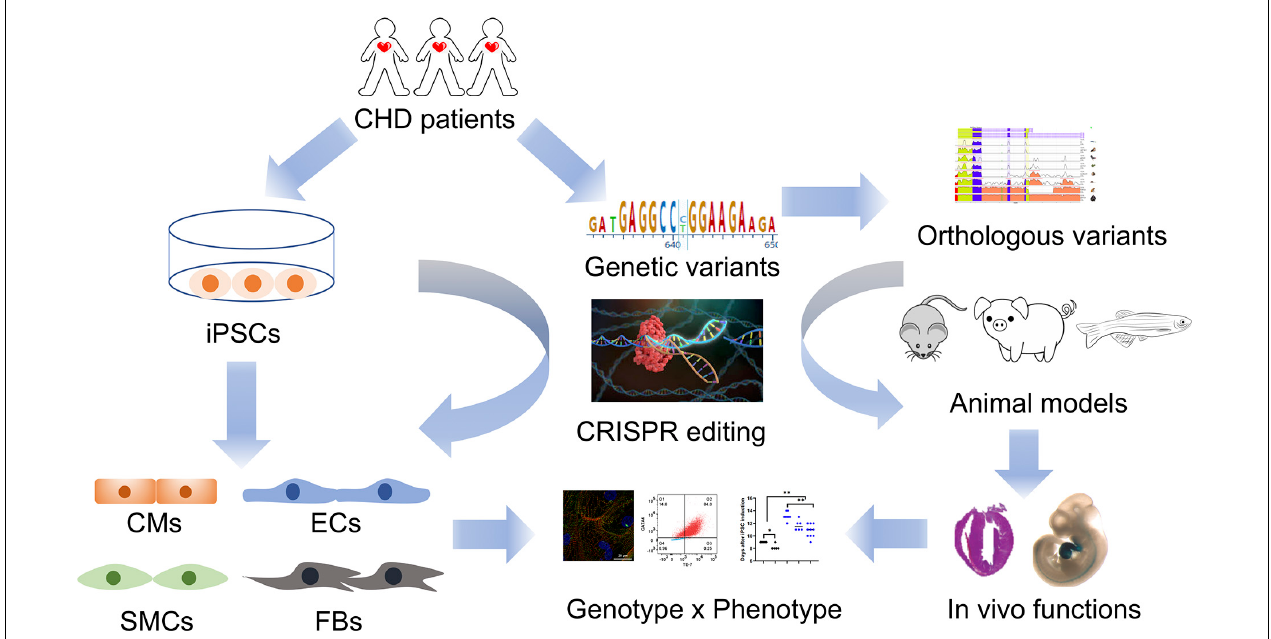
FIGURE 1 | An integrated patient-specific iPSC model for studying genetics of CHD. Whole genome sequencing of CHD patients identifies prospective genetic variants that are retained in patient-specific iPSCs. Cardiovascular defects in CHD are recapitulated in patient iPSC-derived cardiac cells, such as cardiomyocytes (CMs), endocardial/endocardial cells (ECs), vascular smooth muscle cells (SMCs), and fibroblasts (FBs). Genetic variants associated with a CHD phenotype are corrected in diseased iPSCs and introduced to healthy iPSCs using CRISPR/Cas9 genome editing tools. These genome-edited iPSCs are further investigated to validate the cause-effect relationship between a given genetic variant and a CHD phenotype. In parallel, orthologous variants are genetically introduced into animal models (rodents, pigs, zebrafish, etc.) in order to investigate the in vivo effects of a given human variant on heart development. Together, an integrated model including both genome-edited human iPSCs and transgenic animals will yield a more comprehensive illustration of the genetic basis of CHD in the new era of genomic